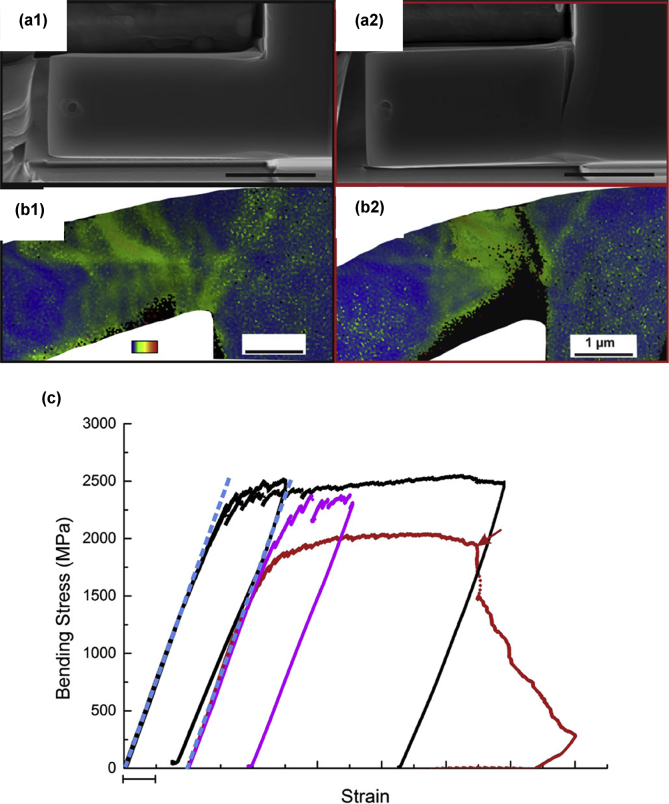
The use of micro-cantilevers to study hydrogen embrittlement within an ESEM in vacuum: (a1) micro-cantilever in top-down view before exposure to water vapour and applied stress; (a2) following exposure and stress; (b1) EBSD KAM map of micro-cantilever, side view, before exposure to water vapour and appied stress; (b2) after exposure and applied stress; (c) stress-strain curve for micro-cantilevers exposed to the hydrogen charging environment. From Deng et al. [2017].46